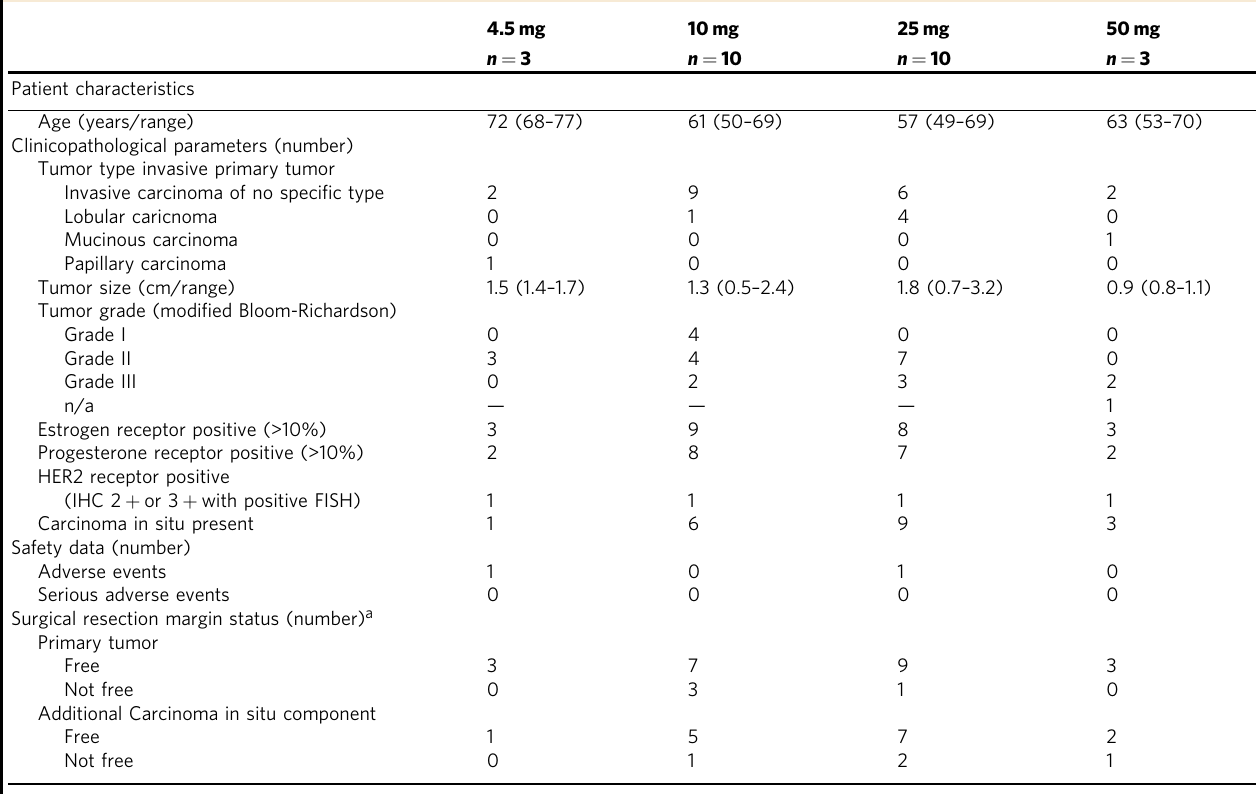
Table 1 Demographics of study